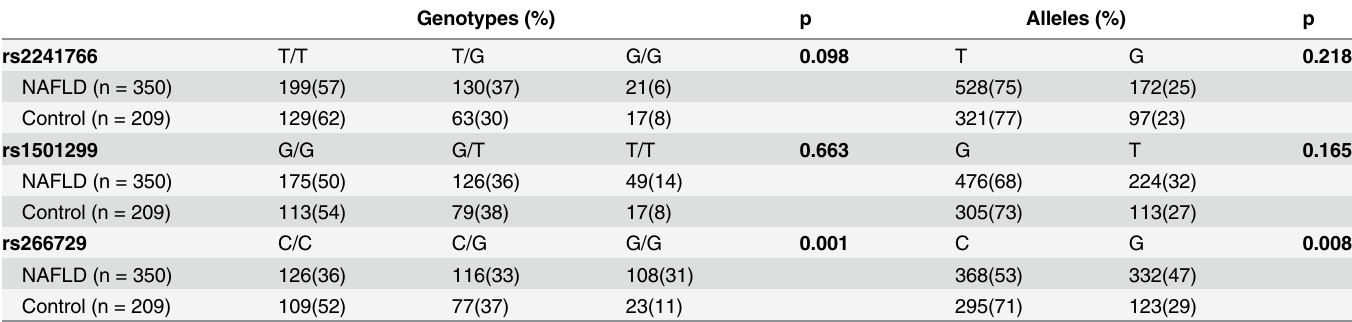
Table 4. The Genotypes and Allele Distribution of the adiponectin Gene Polymorphisms in Case (Type 2 DM with NAFLD) and Control Groups (Type 2 DM without NAFLD).